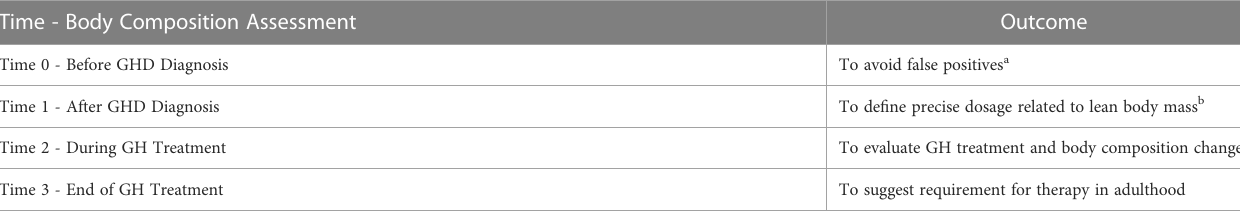
TABLE 4 Suggested timing and reasons for body composition assessments children with